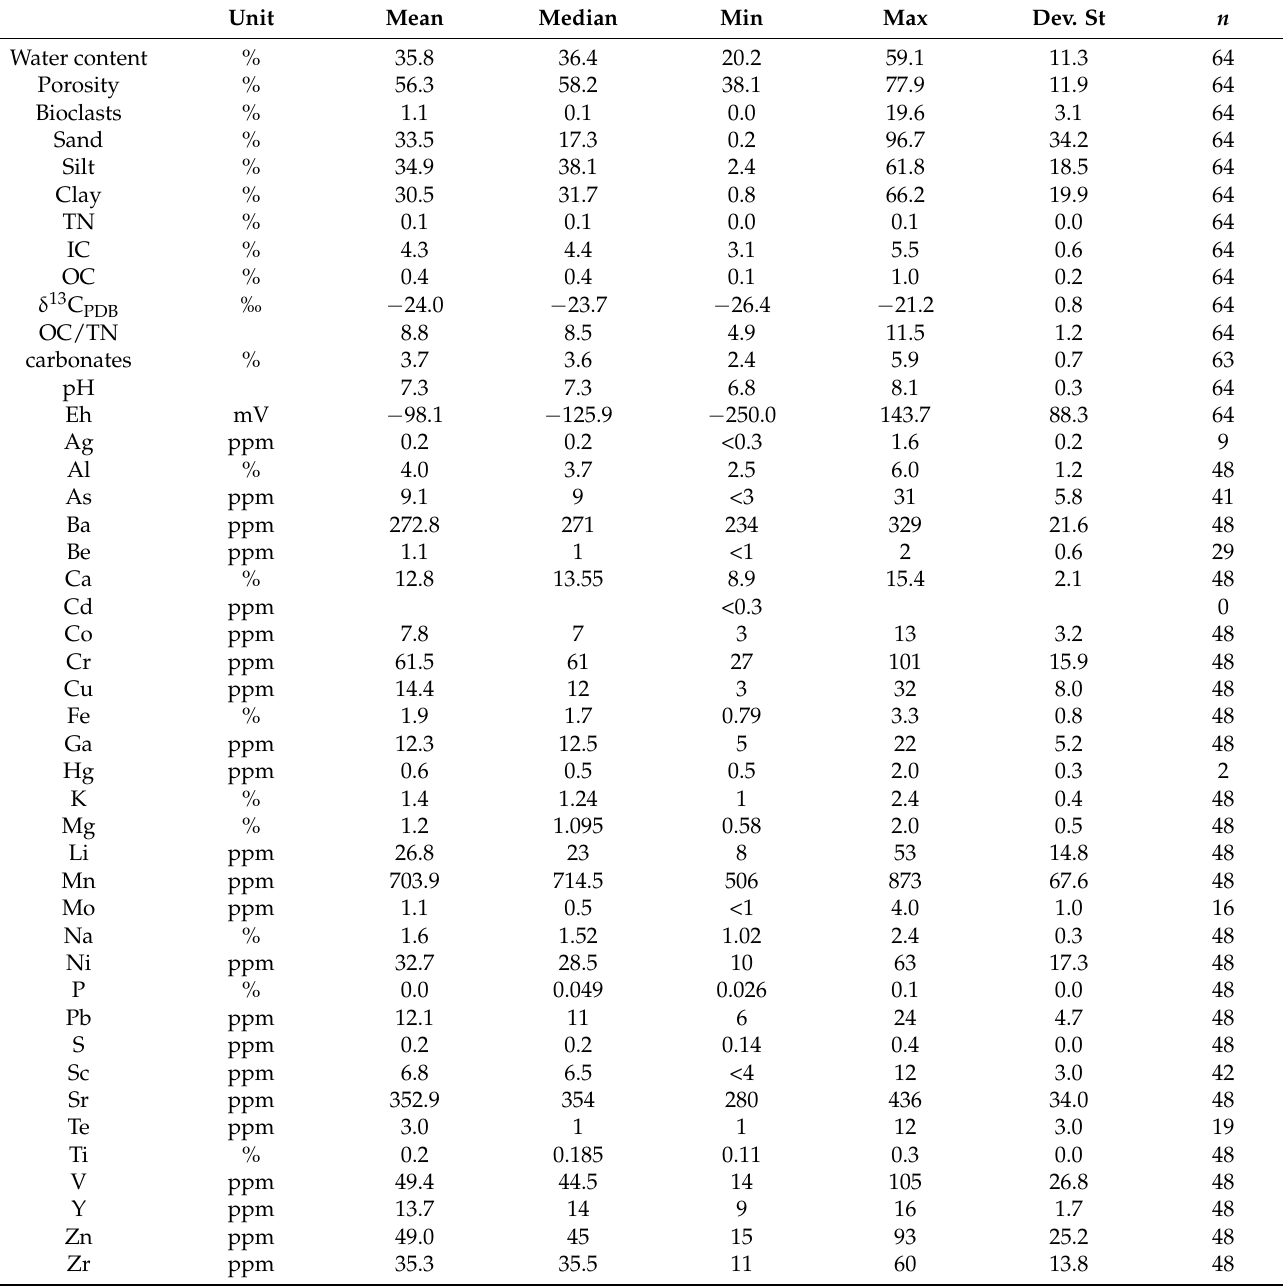
Table 3. Summary statistics for the investigated